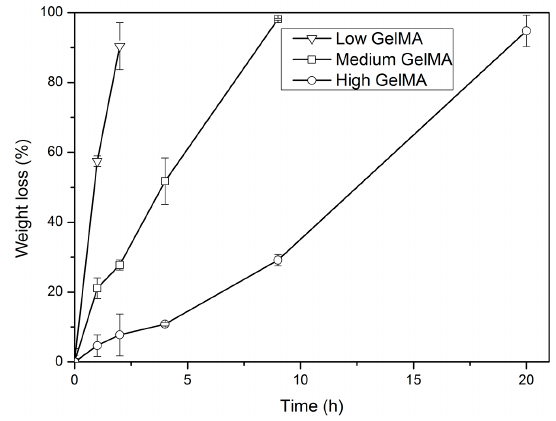
Figure 4. Enzymatic degradation of GelMA hydrogels in the presence of 10 unit·mL − 1 of collagenase at 37 °C. Means ± SD, n = 3.